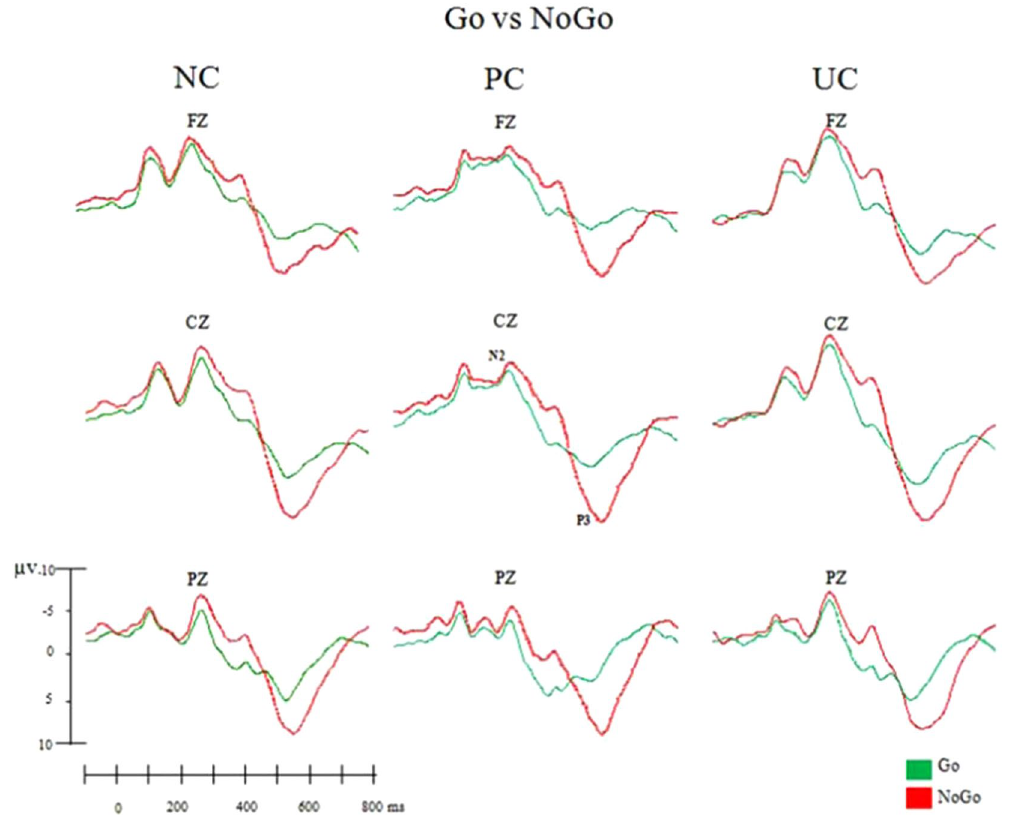
Figure 1. Comparison of ERP waveforms between Go and NoGo trials in each context condition: neutral (NC), pleasant (PC) and unpleasant